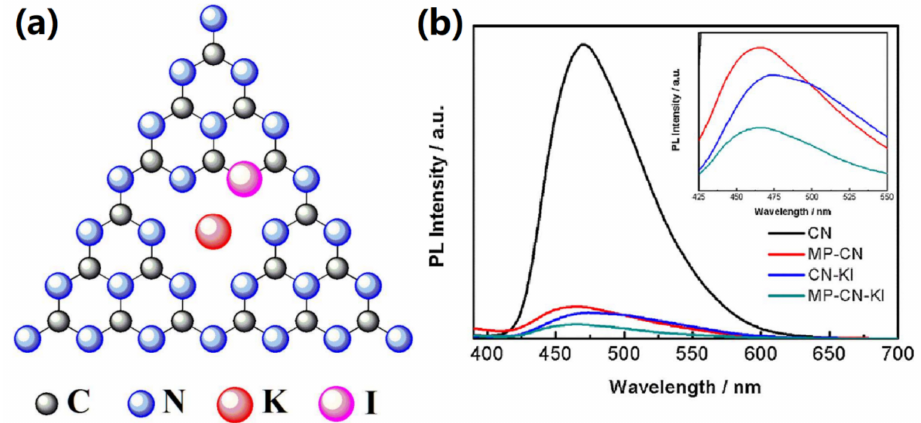
Figure 8. ( a ) The proposed structure of K, I-GCN, and ( b ) PL spectra of pure GCN, mesoporous GCN, K, I-GCN, and mesoporous K, I-GCN. Reproduced with permission from Ref.